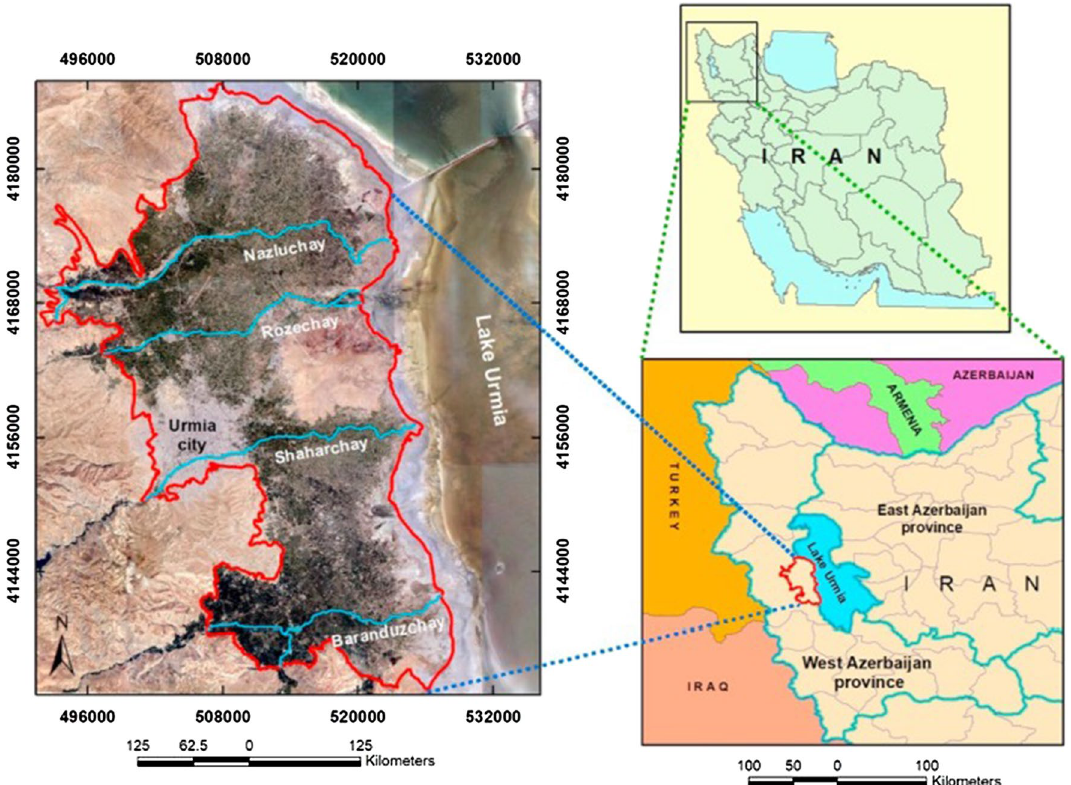
Fig. 1 Map of studied